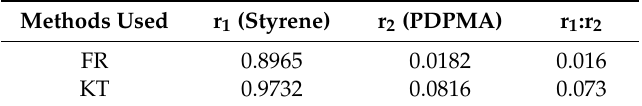
Table 3. Reactivity ratio of styrene (r 1 ) and PDPMA (r 2 ) determined by di ff erent methods.